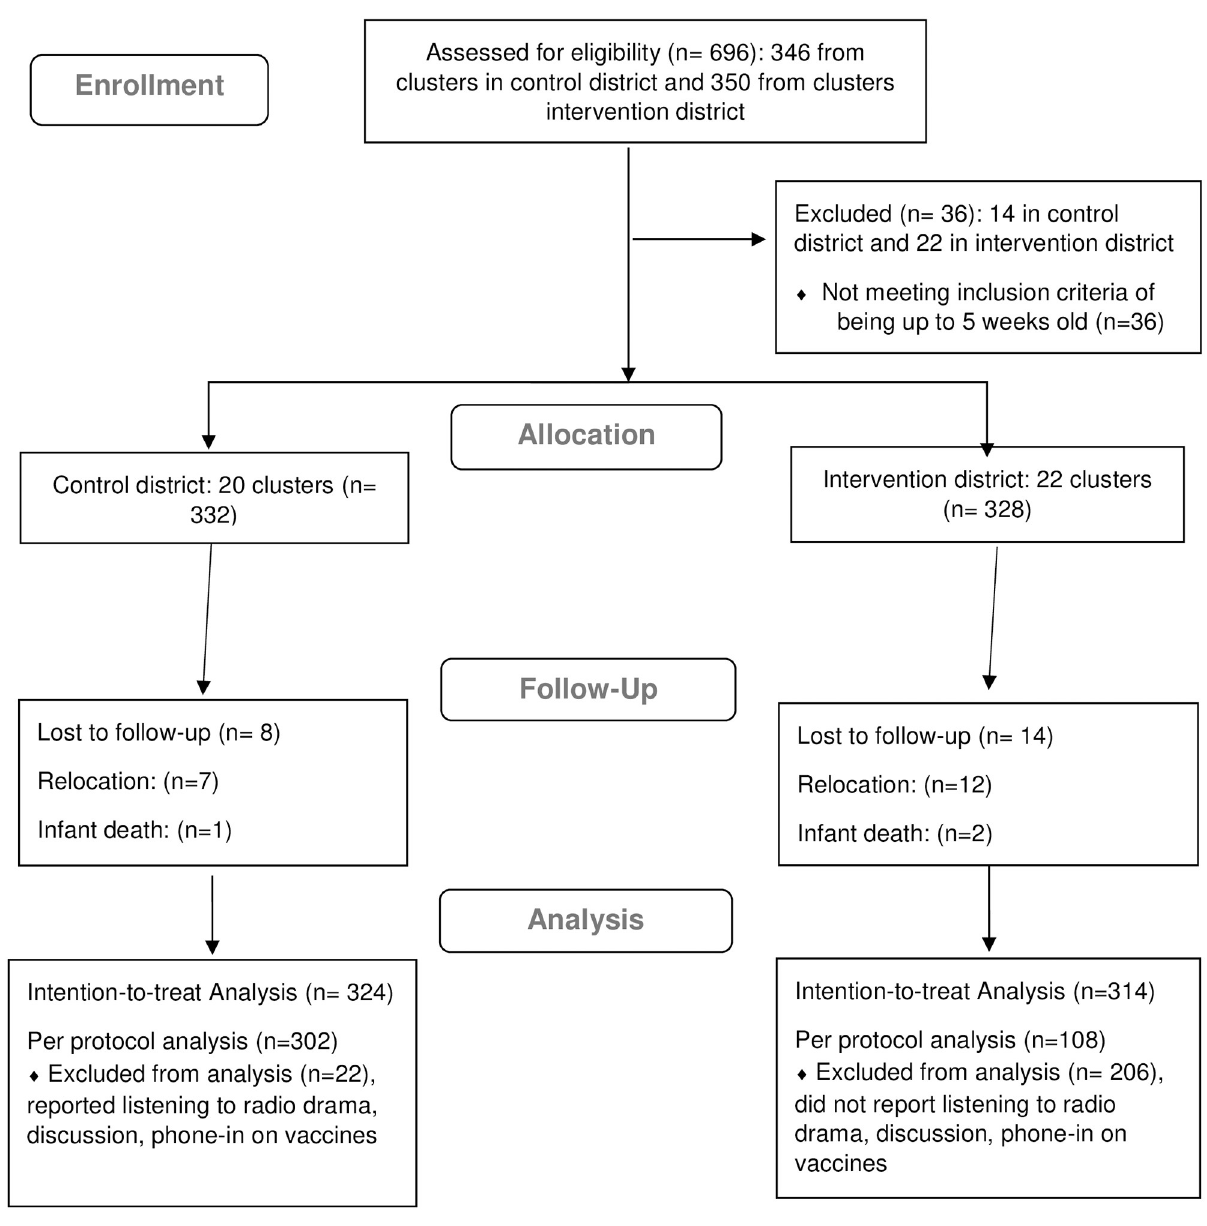
Fig 2. Flow diagram of 10+10+30 intervention